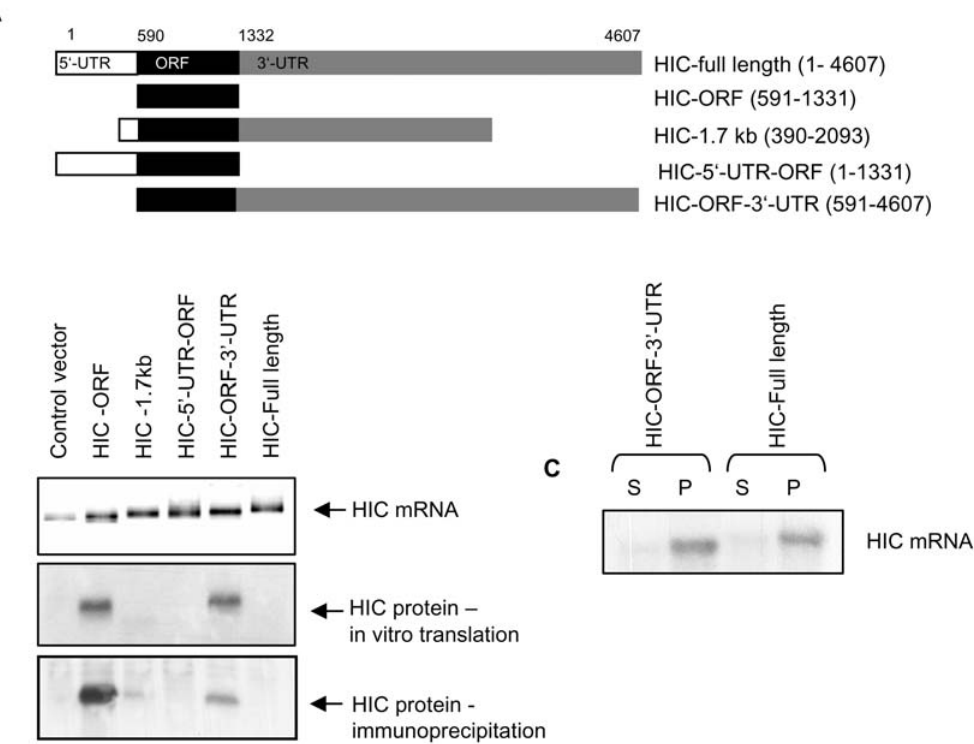
Figure 3. Translation of HIC is repressed by its 5 9 -UTR in vitro and in cells. A. Schematic representation of HIC fragments encoding the coding region or the coding region and various fragments of the HIC UTRs expressed from a pcDNA3 vector. B. Upper panel- Ethidium bromide stained gel of the RNAs transcribed in vitro using the different constructs in A. Middle panel- translation products from each RNA, translated in vitro in a reticulocyte lysate system in the presence of L-[35S]-methionine and L-[35S]-cysteine. Translation products were subjected to SDS-PAGE and visualized by autoradiography. Lower panel- Immunoprecipitation of HIC protein from HEK-293 cells transfected with the various HIC constructs. 24 h after transfection cells were metabolically labelled using L-[35S]-methionine and L-[35S]-cysteine for 11 hr. HIC was immunoprecipitated using anti- HIC serum, subjected to SDS-PAGE and visualized by autoradiography. C. Polysomal analysis of HEK-293 cells transfected with the HIC-ORF-3 9 UTR construct or a construct expressing the full length HIC mRNA. 24 h after transfection cytoplasmic extracts were prepared, fractionated by sucrose gradients and separated into polysomal (P) and sub-polysomal (S) fractions. RNA was analyzed by Northern blot using a probe for the HIC gene.